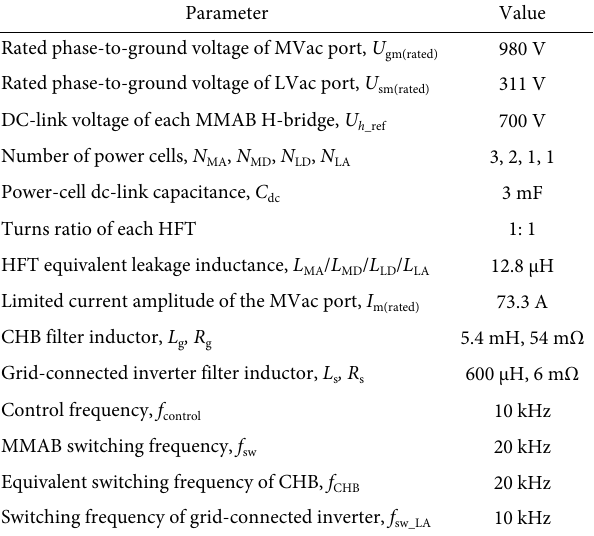
Table 3 Power stage parameters of the four-port PET Parameter